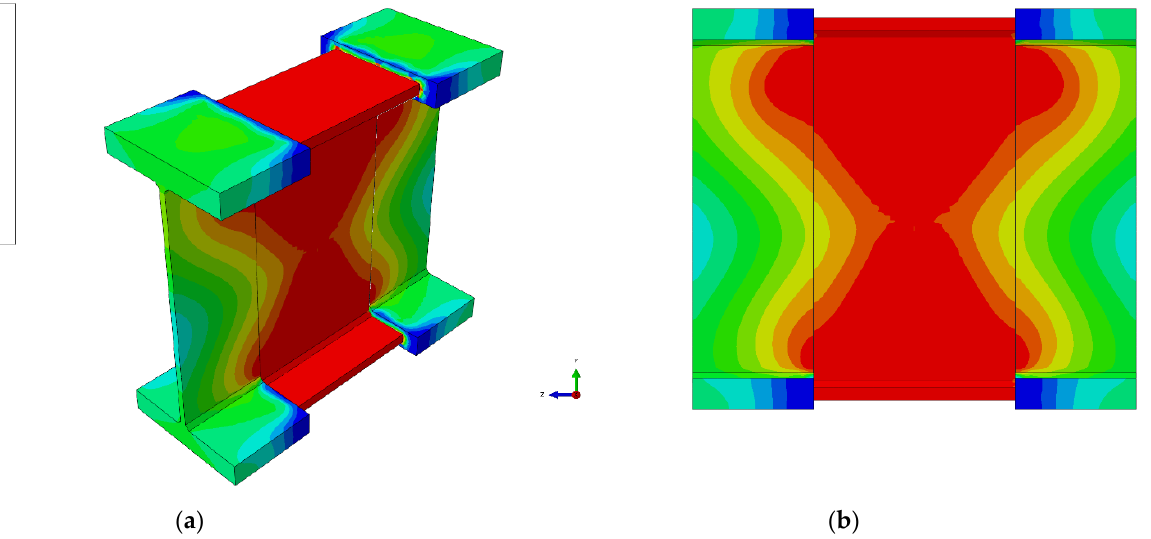
Figure 15. von Mises’ stress map (MPa) for LRPD IPE400 (DP1) at the ultimate loading condition: ( a ) perspective view; ( b ) lateral view.